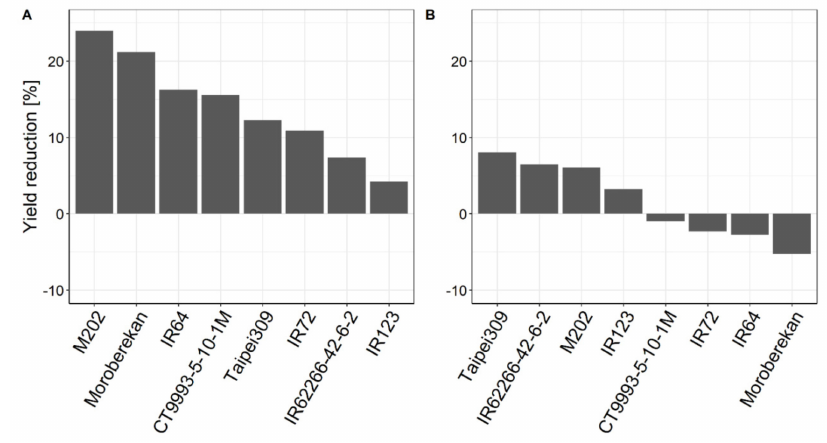
Figure A3. Yield reduction under HNT in the WS ( A ) and DS ( B ). Cultivars are sorted from highest to lowest yield